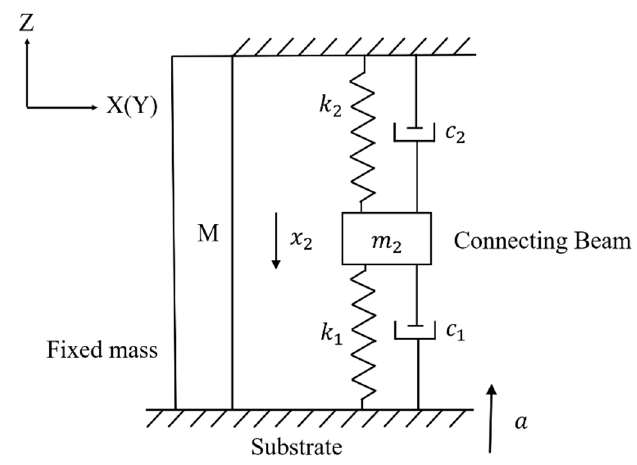
Figure 2. Model of a MEMS tuning fork gyroscope transformed from Figure 1c when the movable mass adheres to the substrate.